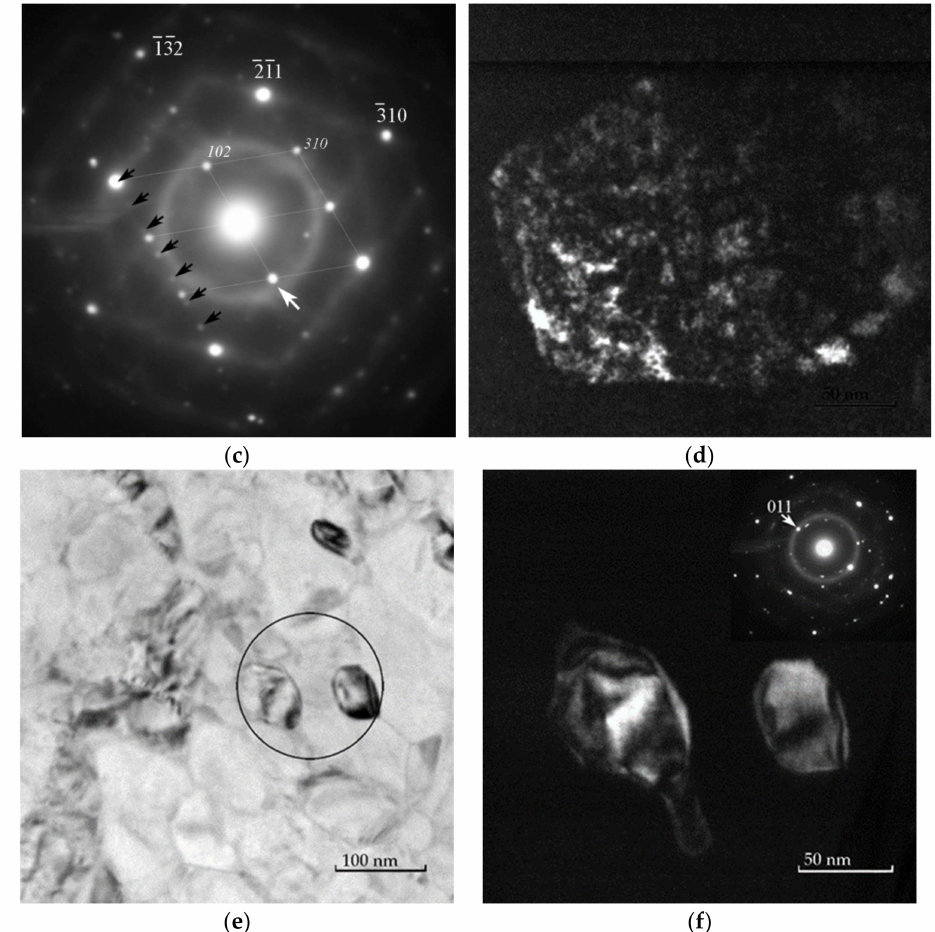
Figure 2. Structure of Ti-50.9Ni after annealing at 300 ◦ C: ( a ) bright-field image of sub- grains and corresponding SAED pattern, arcs correspond to the positions of reflections of B2, ( b ) bright-field image of large grain with “coffee bone” contrast indicative of the presence of coherent Ti 3 Ni 4 particles, ( c ) corresponding SAED pattern showing weak reflections of Ti 3 Ni 4 particles in positions 1/7 along the B2 lattice directions <321> (dark arrows), zone axis [135], the R-phase reciprocal lattice section is indicated by white lines, ( d ) R-phase dark-field image in a (102) reflection indicated by white arrows on ( c ), ( e , f ) bright-field image of dislocation-free grains and corresponding dark-field in (011) reflection of B2 on SAED